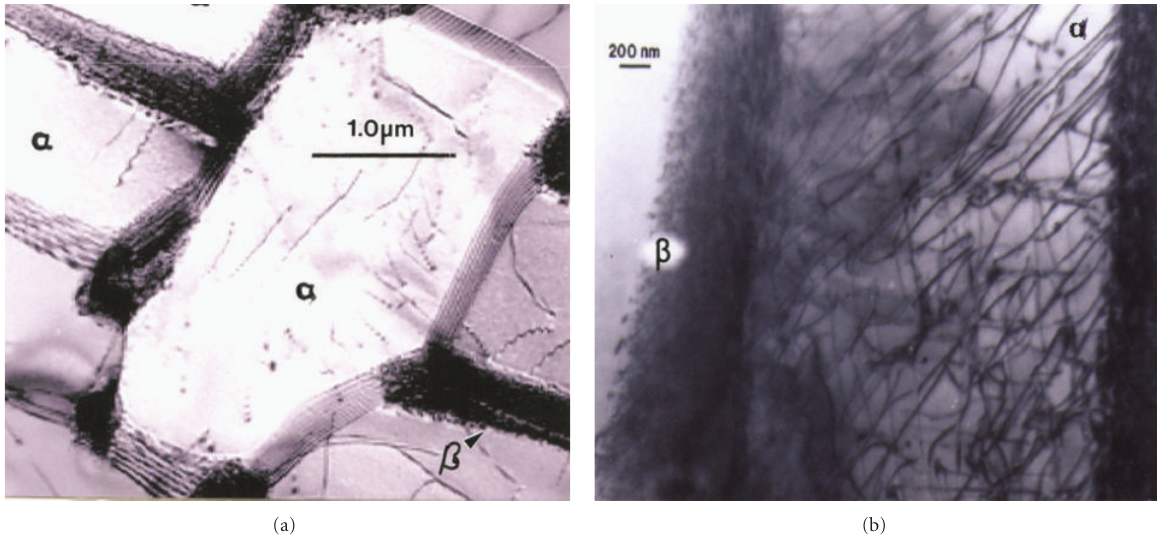
Figure 10: TEM image comparison for dislocation substructures in EBM-fabricated Ti-6Al-4V components as in Figure 9(a). (a) Low dislocation density and shallow β wall thickness surrounding α -phase grains. (b) High dislocation density and thicker β phase surrounding α -grains. Hardness in (a) and (b) was HV 3.6 and 3.9GPa,